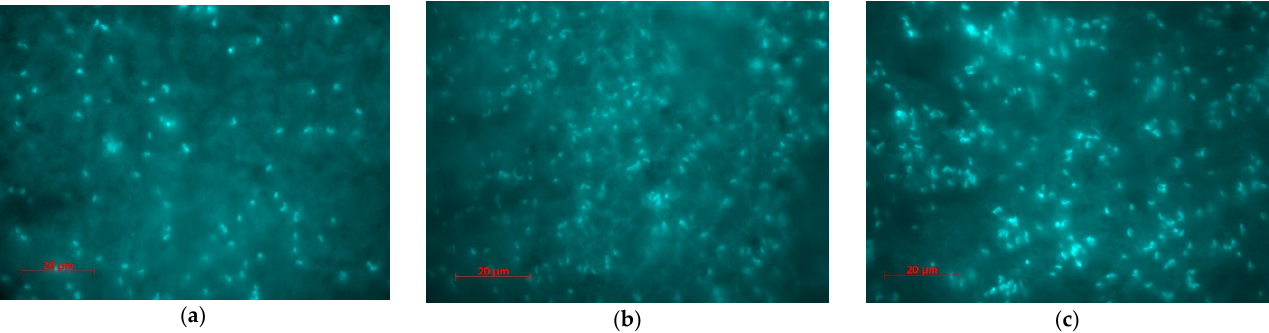
Figure 10. Epifluorescence Microscopy (EFM) image of the Sulphate reducing bacteria (SRB) attachment and extracellular polymeric substances (EPS) formed on tested samples surfaces: ( a ) sample A, ( b ) sample B, ( c ) sample C.